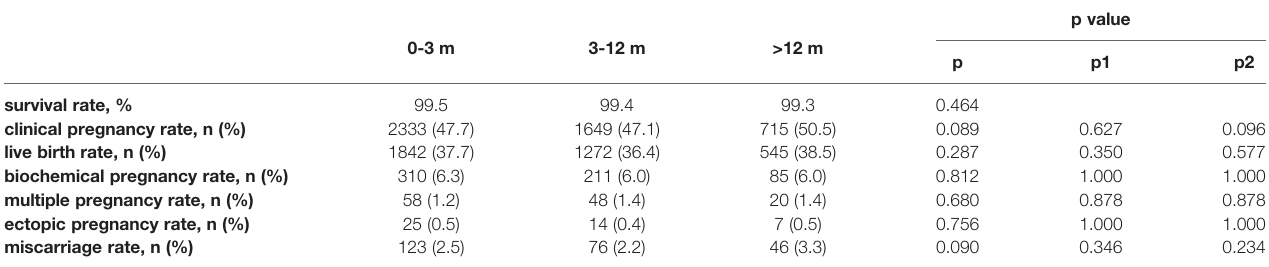
TABLE 2 | The results of pregnancy outcomes.